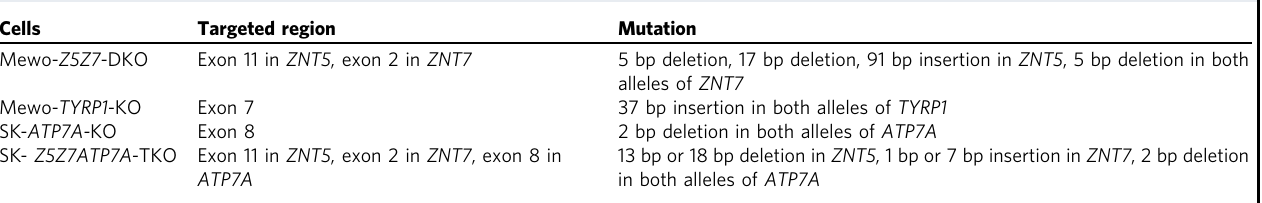
Table 1 Mutations introduced in ATP7A , TYRP1 , ZNT5 , and ZNT7 in cells used in this